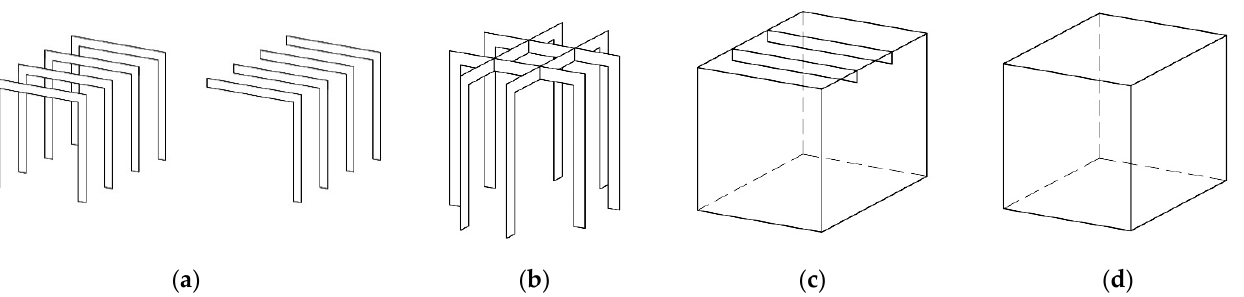
Figure 18. Typology of glass structural systems used in all-glass objects: ( a ) frames; ( b ) grillages; ( c ) beam-wall systems; and ( d ) plate-wall systems (figures by the author).